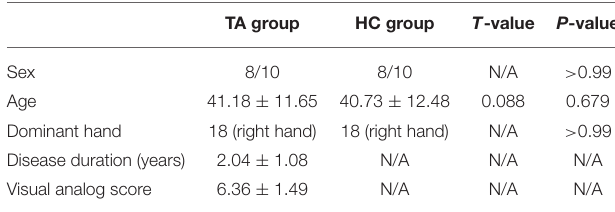
TABLE 1 | Comparison of baseline data between toothache patients and healthy